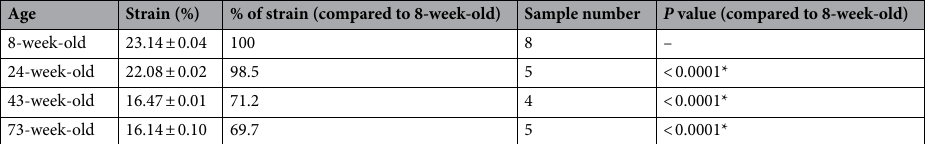
Table 1. The elasticity of young, middle and aged rat lenses was measured with a force–displacement measuring instrument. As shown in Fig. 1d, the lenses extracted from young (8-week-old, n = 8), middle (24-week-old, n = 5 and 43-week-old, n = 4) and aged (73-week-old, n = 5) male rats were assessed. The percentages of strain for the four age groups when lenses were pushed with 0.05 newtons (N) of force are shown. Data are presented as mean ± SEM. The asterisk indicates a statistically significant difference compared to 8-week-old (* P < 0.05, one-way analysis of variance followed by Tukey’s post-hoc test).